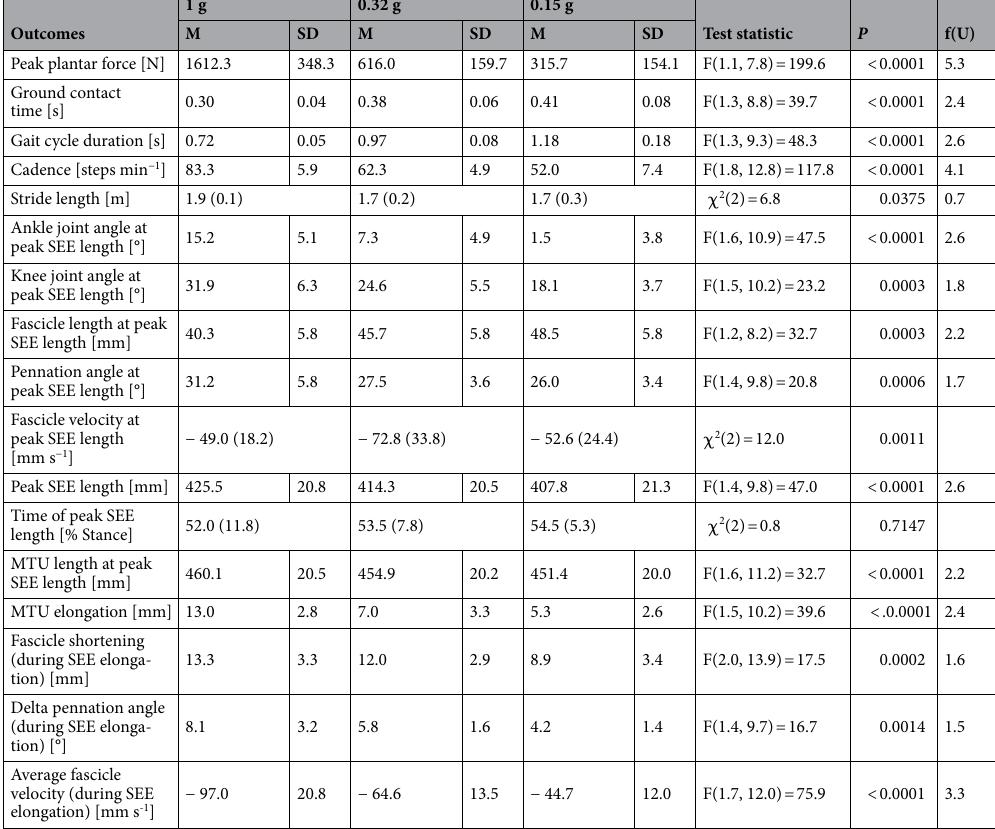
Table 1. ANOVA results for kinetic, spatio-temporal, kinematic, gastrocnemius medialis fascicle and series elastic element parameters while participants ran at 125% PTS at 1 g and simulated Martian and Lunar gravity. PTS preferred walk-to-run transition speed, M mean, SD standard deviation, P result of the ANOVA (F-statistic) or Friedman test ( χ 2 ) indicating a significant effect of g-level (α set to 0.05), f(U) effect size ANOVA; Results of the Friedman test are presented as medians (interquartile ranges). Peak SEE length at 1 g, simulated 0.32 g (Mars), and 0.15 g (Moon) occurred at 52% ± 8%, 54% ± 4% and 53% ± 5% of stance, respectively. Mean and standard deviation for ground contact time, cadence, and joint angles for the 1 g condition have been previously published by Richter et al. 19 . n =